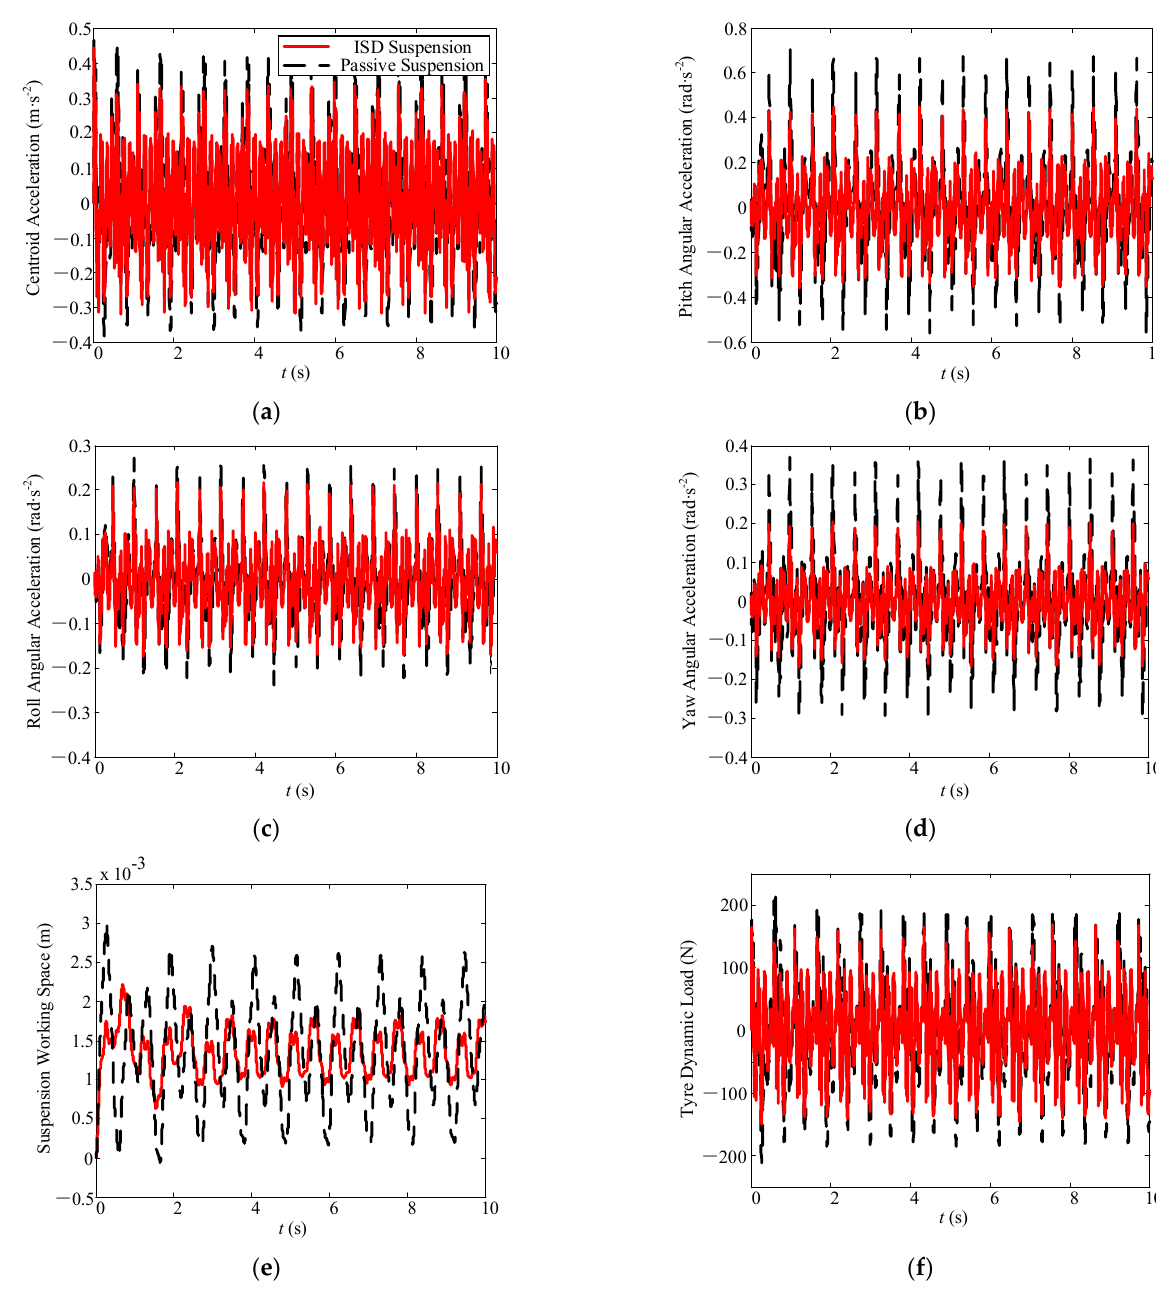
Figure 10. Dynamic characteristics under consecutive speed control humps: ( a ) centroid acceleration; ( b ) pitch angular acceleration; ( c ) roll angular acceleration; ( d ) yaw angular acceleration; ( e ) suspension working space; ( f ) tyre dynamic load.